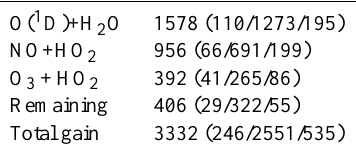
Table 8. The tropospheric chemical production of OH given in Tg OH yr − 1 . The distribution for the SH extra-tropics/tropics/NH extra-tropics are given in